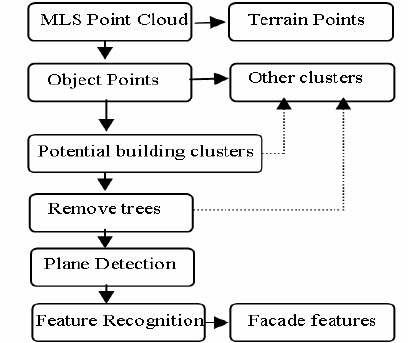
Figure 1. Processing flowchart for building facade feature extraction